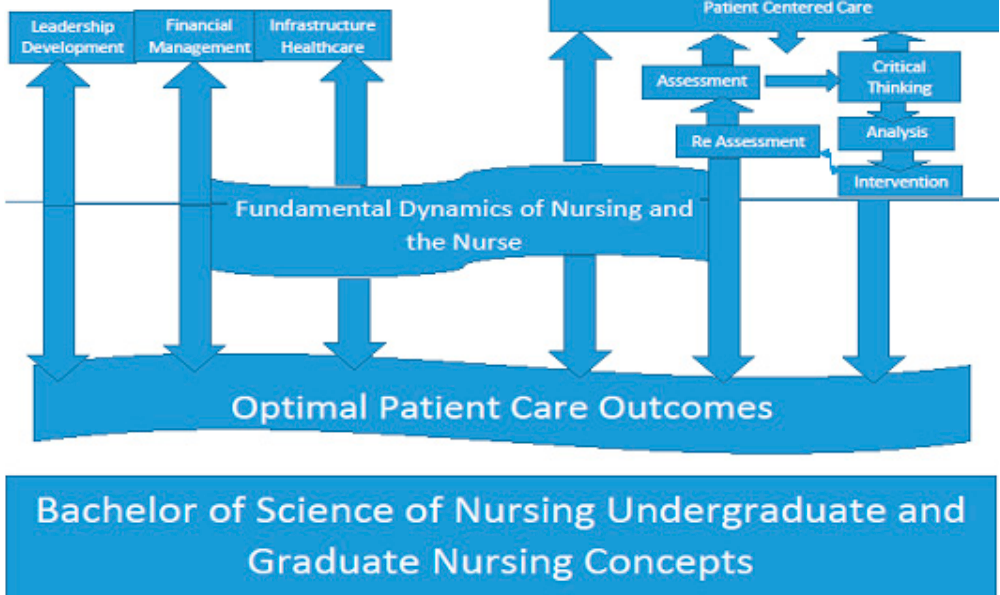
Figure 1. An adaption of universal Leadership and Nursing components combined by Ingwell-Spolan (2017) into the Nursing undergraduate and graduate nursing concepts.